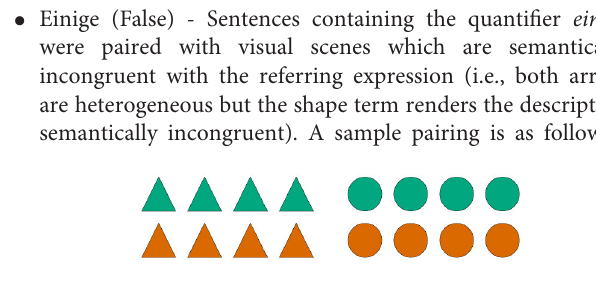
English gloss: “All of the circles in the picture are